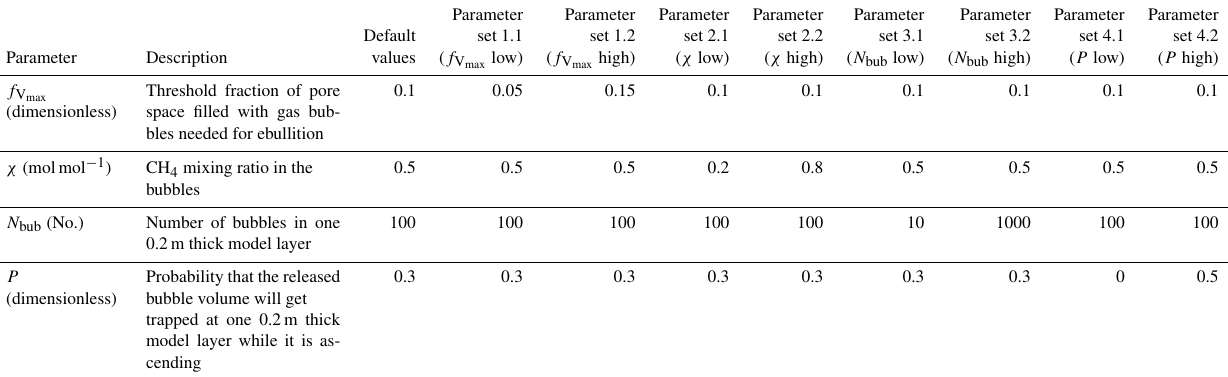
Table 1. Parameters needed in the EBG ebullition module. Default values are given, along with different values used in the sensitivity